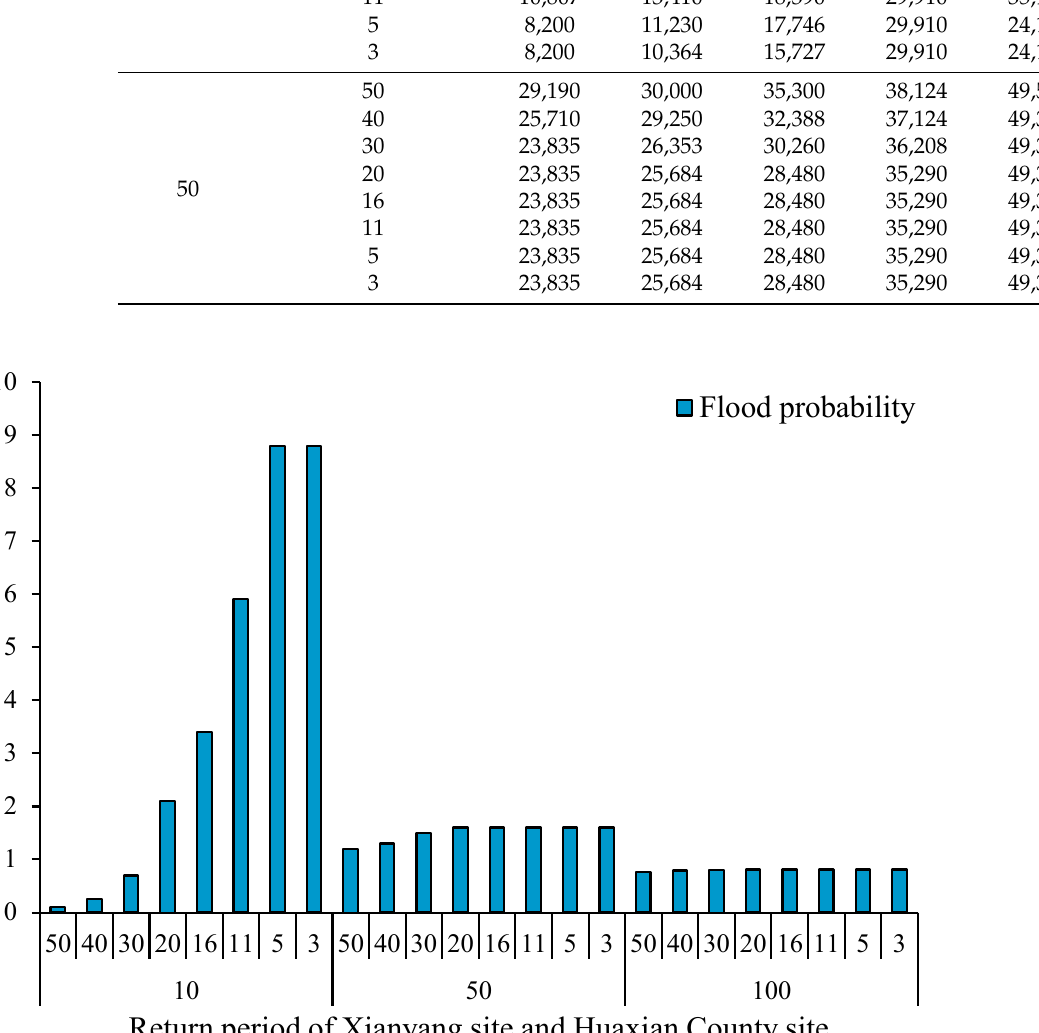
Figure 13. Flood peak volume of Zhangjiashan under different return periods of Xianyang and Huaxian County.